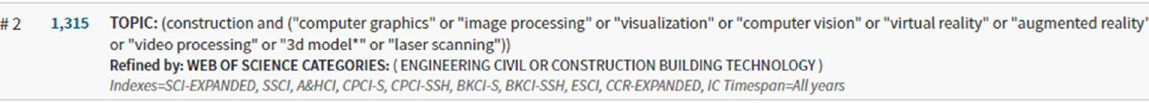
Fig. 2 Search strategy used for searching database of Web of Science